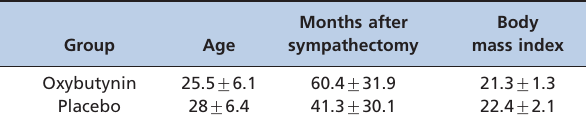
Table 2 - Descriptive analysis of the groups: age, months after sympathectomy and body mass index (mean and standard